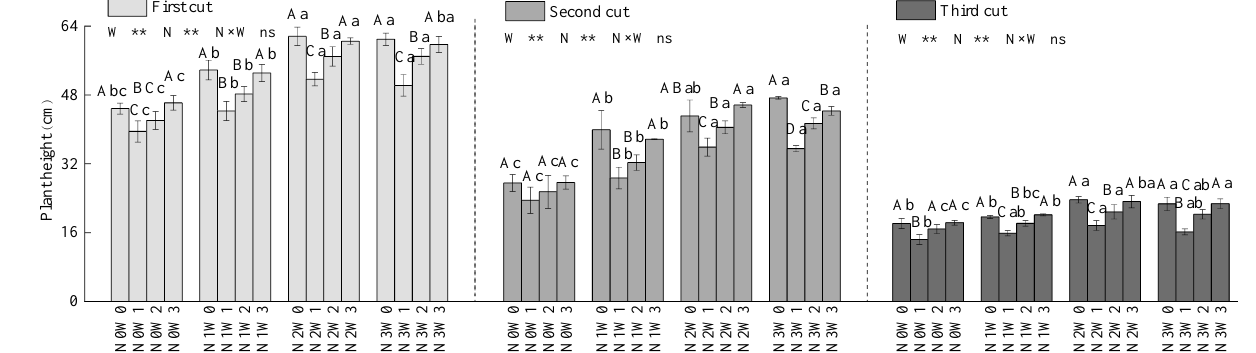
Figure 6. Effects of water-nitrogen regulation on plant height of Bromus inermis. Different capital letters indicate the difference between different irrigation management types under the same nitrogen application level, and different lowercase letters indicate the difference between different nitrogen application levels under the same irrigation management ( p < 0.05). W and N refer to irrigation management and nitrogen application level, respectively; N × W refers to interaction effect between the two. ** indicates an extremely significant difference ( p < 0.01); ns indicates no significant differ- ence ( p > 0.05).